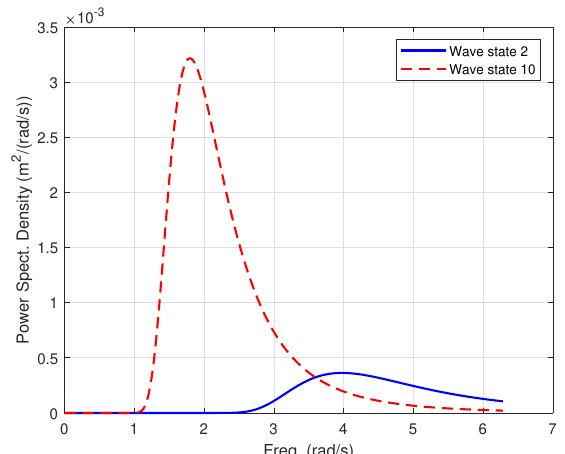
Fig. 5: Nominal power spectral density of the contrast- ing sea-states for which the controller was evaluated. de-trended quantities, with successive windows over- lapping by 255 seconds. The 100 Hz data is first down- sampled to 4 Hz, such that the Nyquist frequency of the resulting estimate 2 Hz, sufficiently high to resolve all relevant dynamics for the examined sea-states. This buffer was then down-sampled again, such that sub- sequent calculations used a buffer updated every 8 seconds of simulated time. A Hamming window